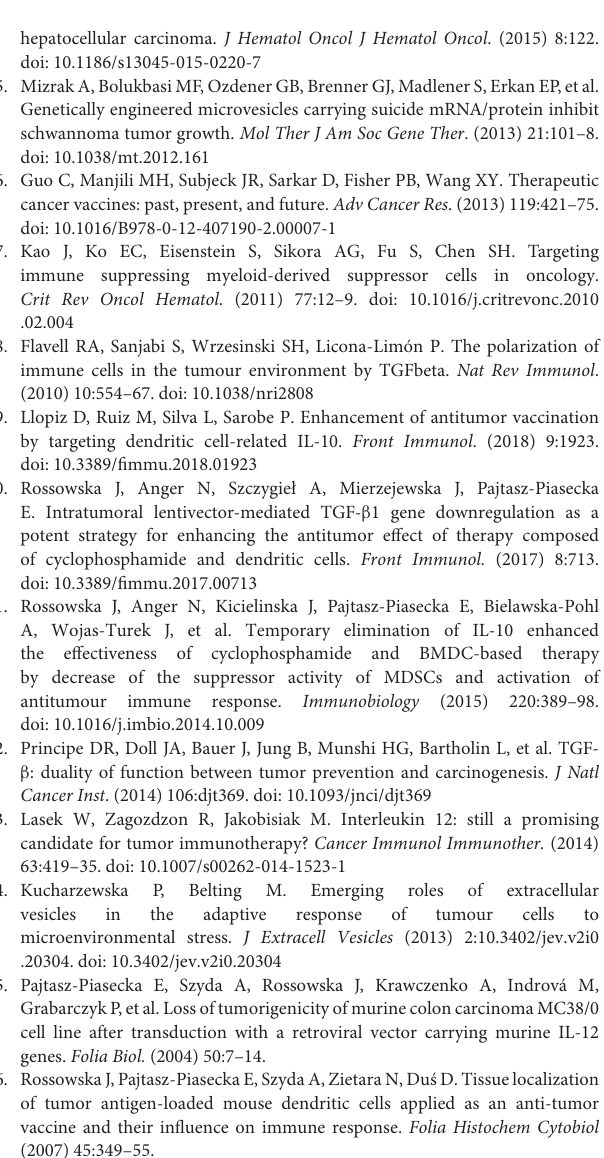
Supplementary Figure 1 | Evaluation of the number of TEx and TMv secreted by the wild-type and genetically modified MC38 cells per isolation performed by flow